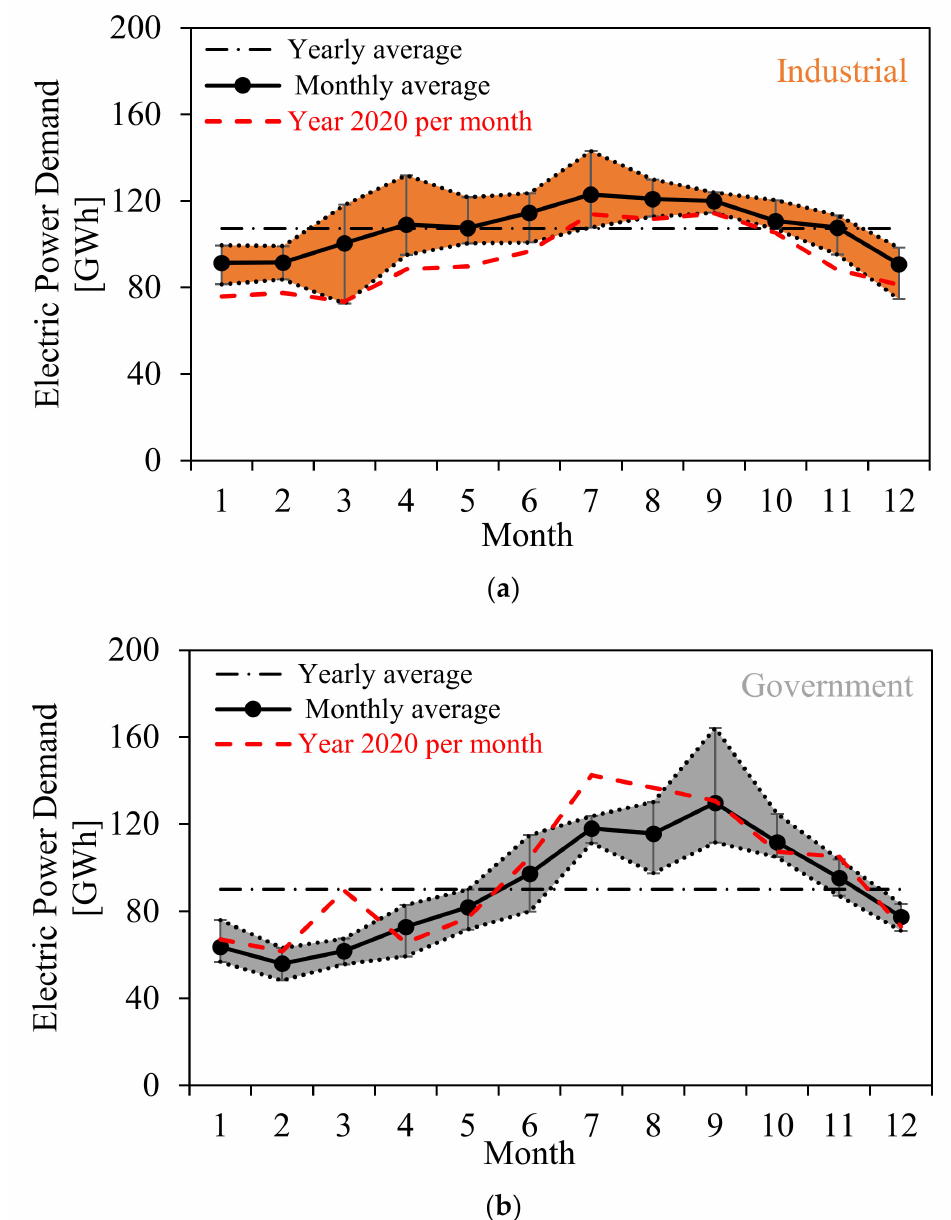
Figure 8. Electric power demand between 2016 and 2019 and an analysis of the demand in 2020 in comparison to the previously reported years for ( a ) industrial and ( b ) government